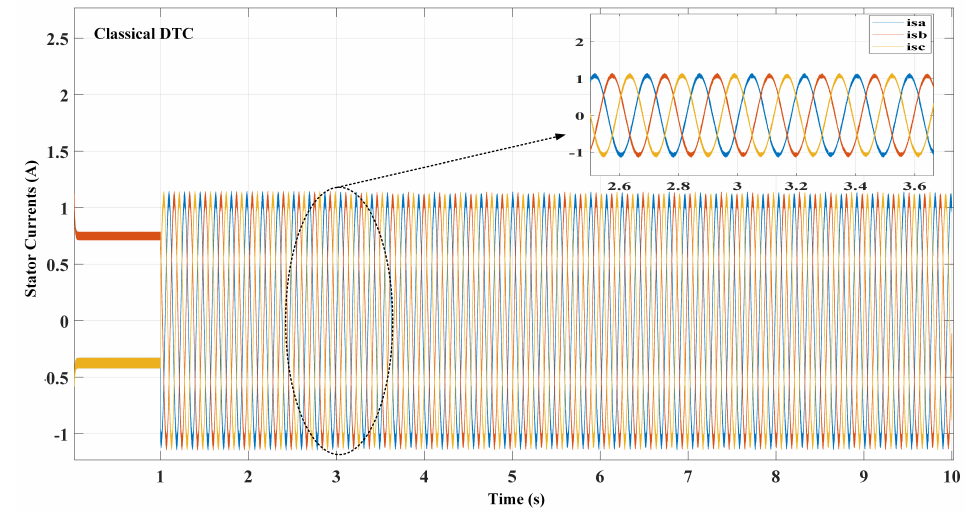
Figure 17. Stator currents of classical DTC for very low speed 5 rad/s.